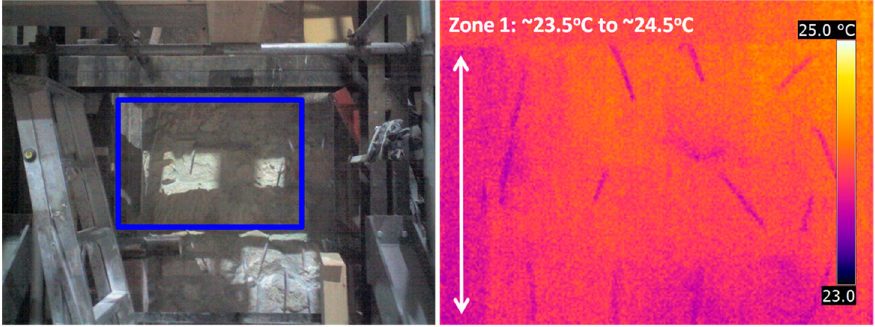
Figure 38. Panel N2 after repointing with installed grout injection tubes and corresponding IRT image.